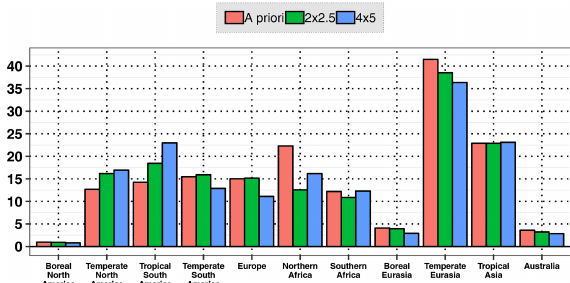
Figure 5. Total CH 4 emissions in the 11 TransCom land regions for the period of February–May 2010. Shown are the a priori emissions (red) and optimized emissions using the 4 ◦ × 5 ◦ ( blue) and 2 ◦ × 2 . 5 ◦ (green) versions of the GEOS-Chem